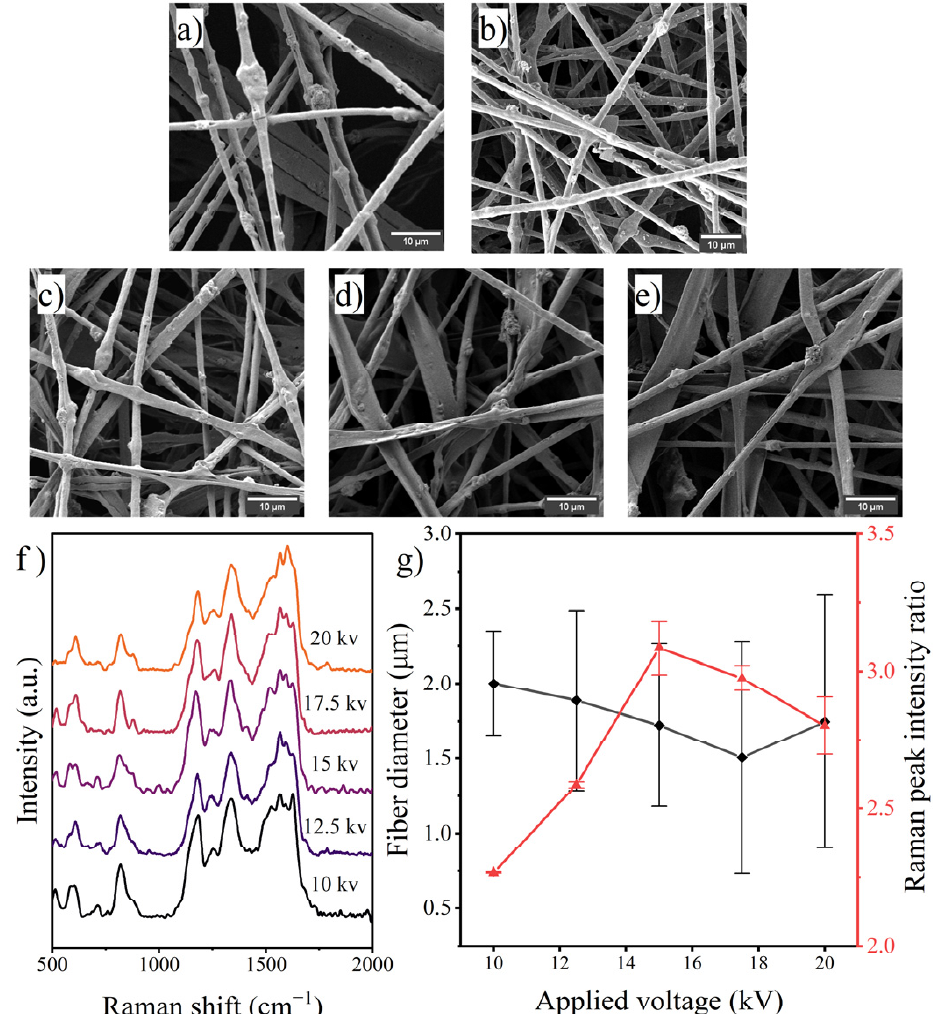
Figure 4. SEM images of fibers prepared with various applied voltages: ( a ) 10 kV, ( b ) 12.5 kV, ( c ) 15 kV, ( d ) 17.5 kV, ( e ) 20 kV; ( f ) Raman spectra of the fibers and ( g ) effects of applied voltage on fiber diameter and surface PANI occupancy.